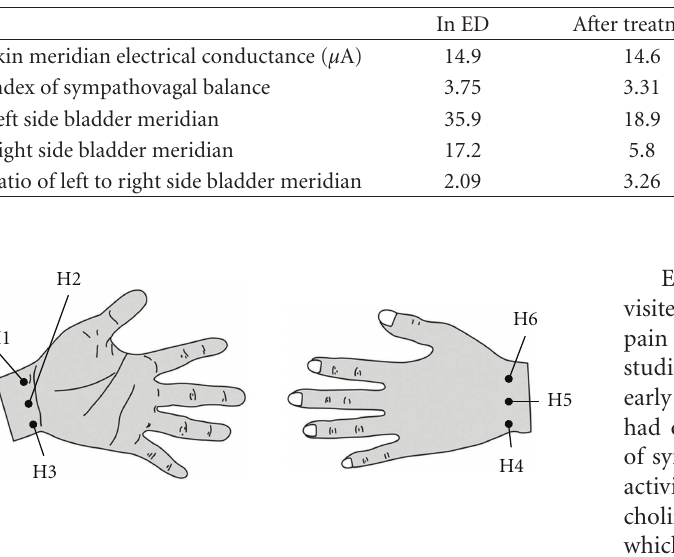
Table 1: The meridian parameters of the patient.